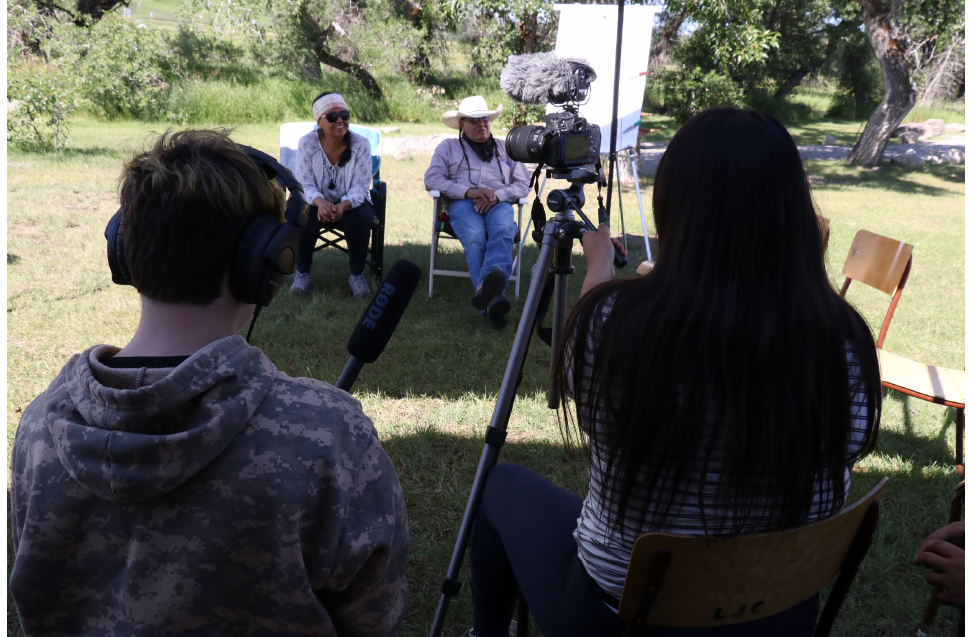
Figure 3: Piikani digital literacy camp